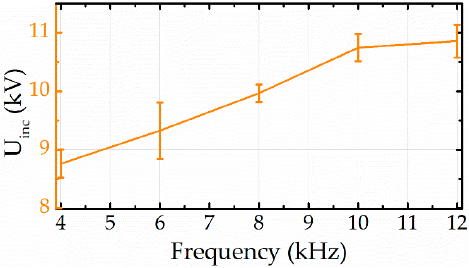
Figure 8. Partial discharge inception voltage at different frequencies.